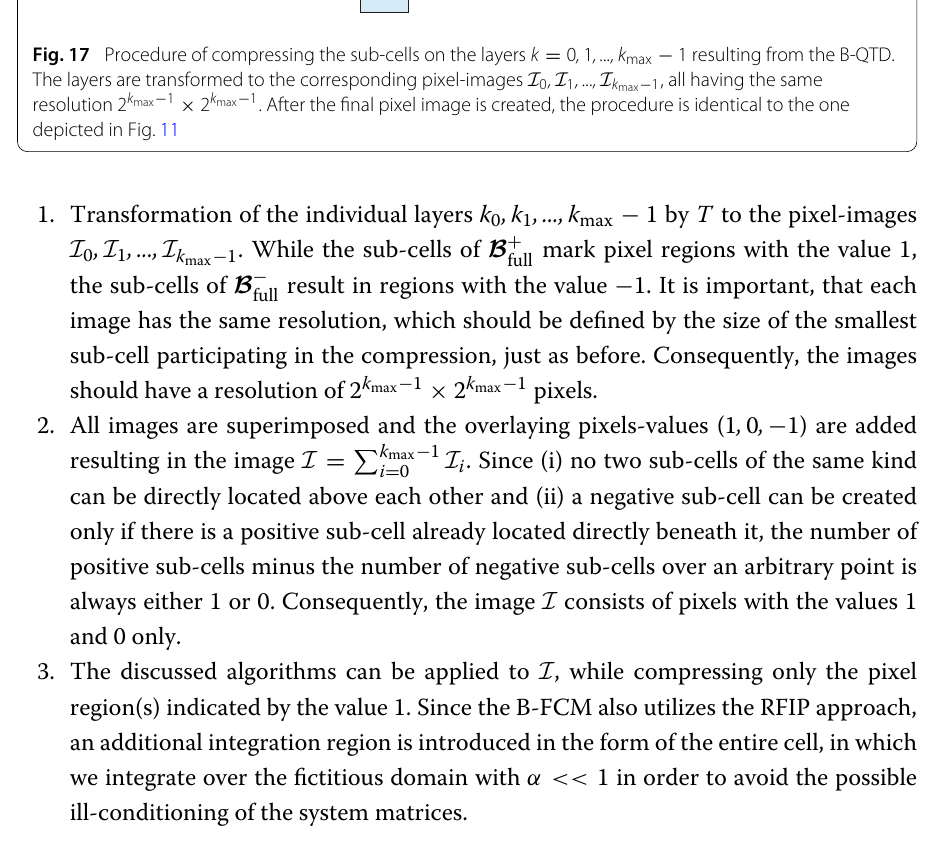
, all having the same max − 1